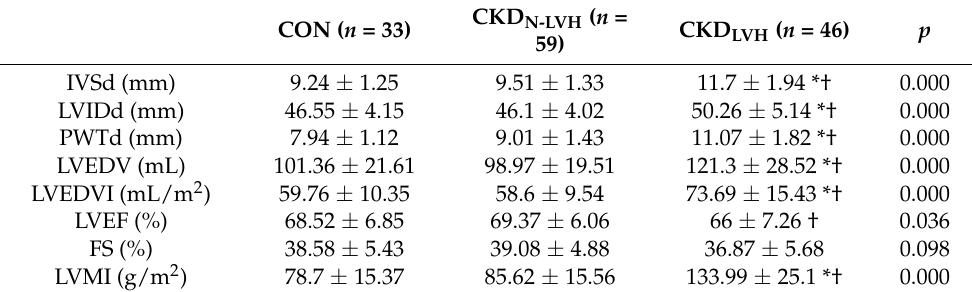
Table 2. Transthoracic echocardiographic